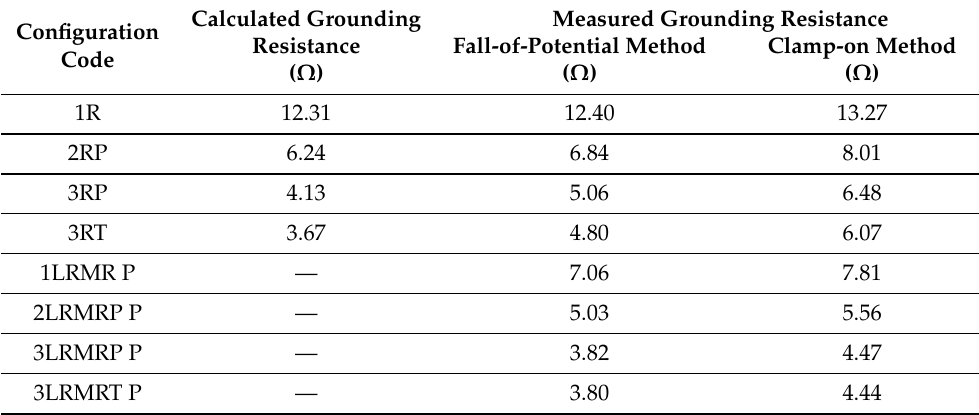
Table 3. GR calculations and measurements in